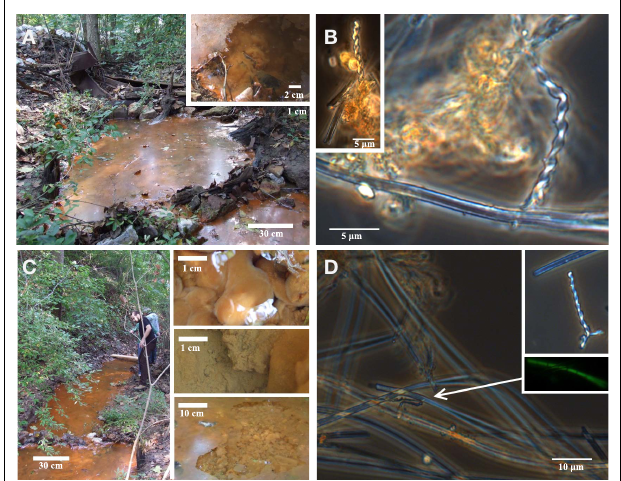
FIGURE 2 | Photos of field site and corresponding light microscopy images. Pool 1 (A,B) is the source zone for the seep; note semi-consolidated Fe(III) oxide mats (inset). Pool 2 (C,D) is downstream from Pool 1; inset shows images of puffball structures. Light microscopy images show stalk and sheath structures typical of microaerophillic FeOB at both sites.